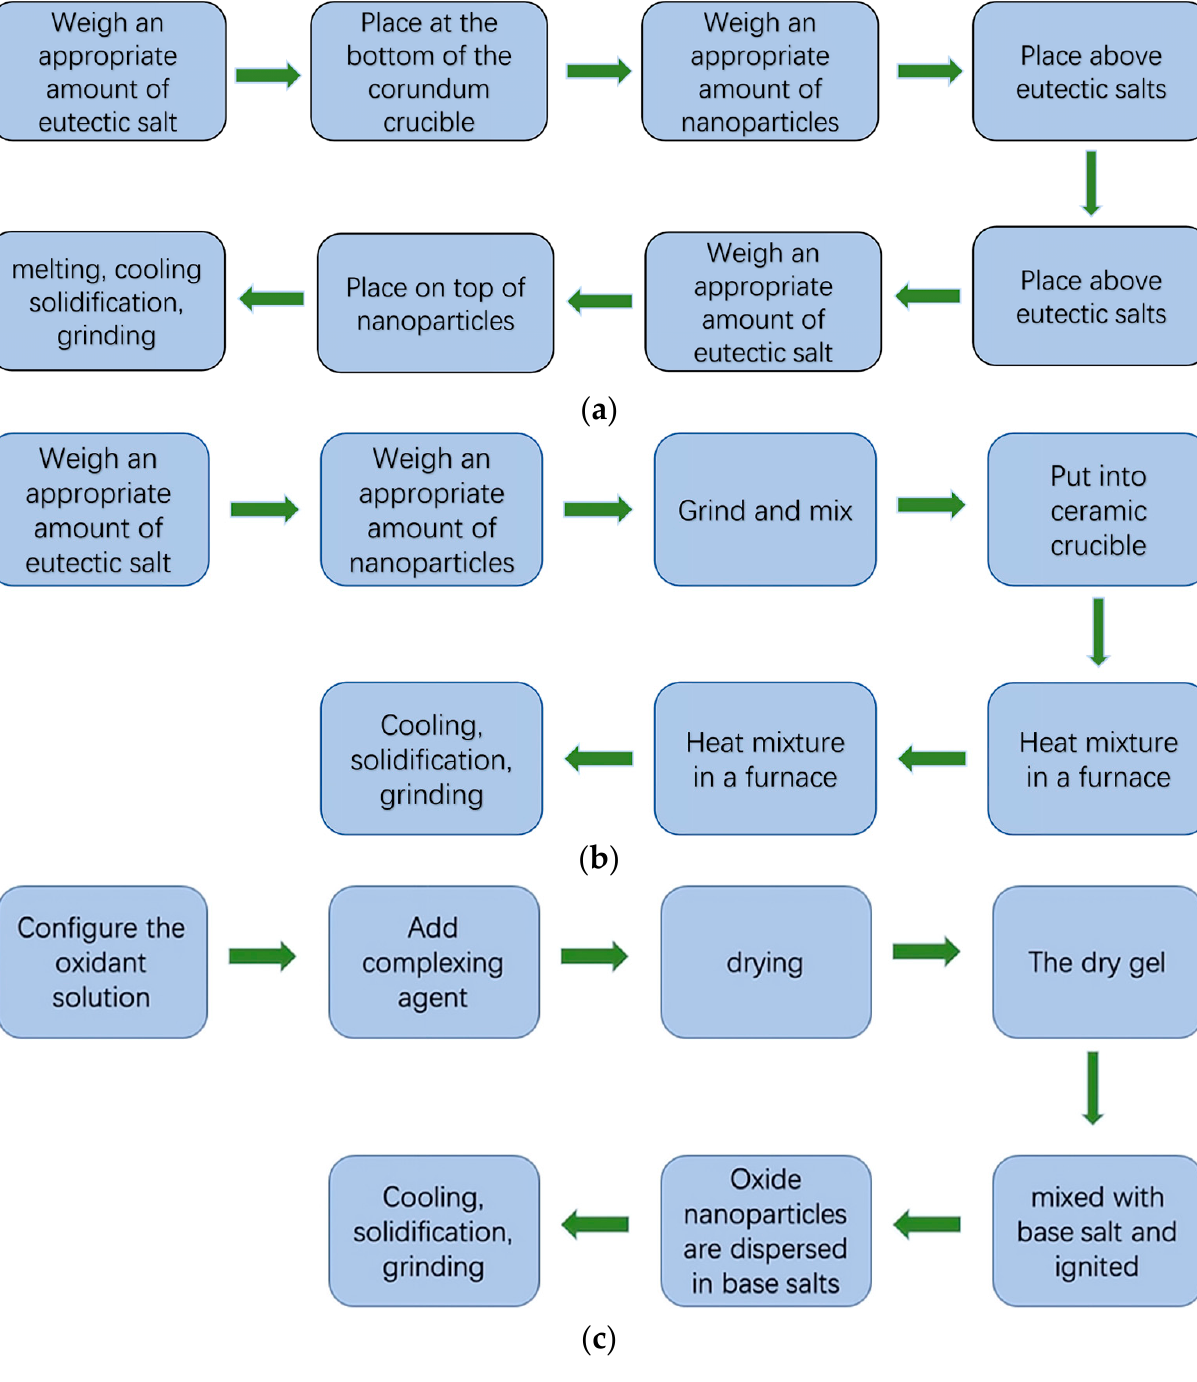
Figure 2. One-step preparation of molten salt nanofluidic flow. ( a ) Dissolution method; ( b ) In situ synthesized; ( c ) Sol–gel self-combustion method.